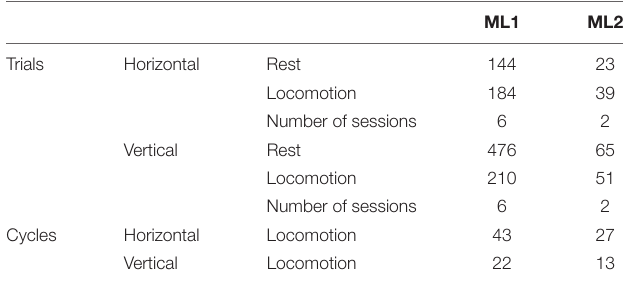
TABLE 1 | Number of trials and cycles per animal and condition.